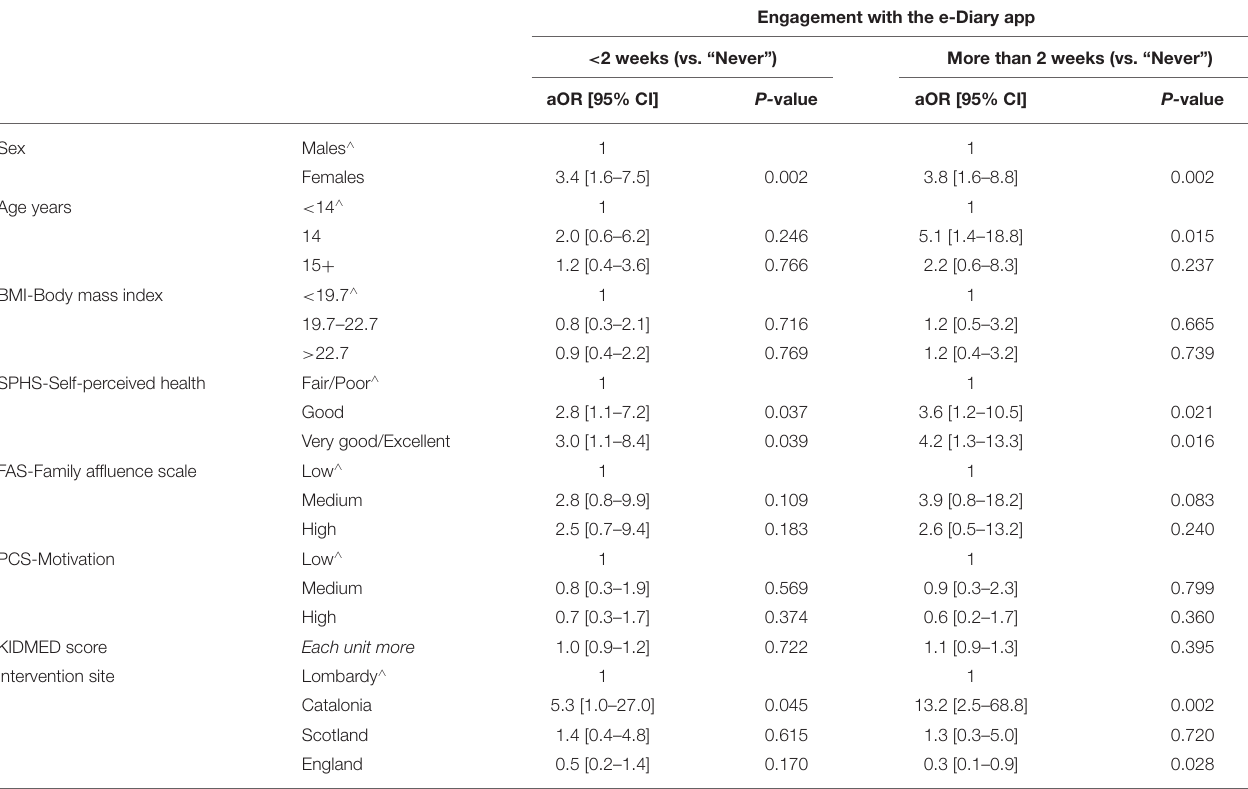
TABLE 4 | Multinomial logistic regression model between baseline characteristics of participants and the engagement with the e-Diary app.